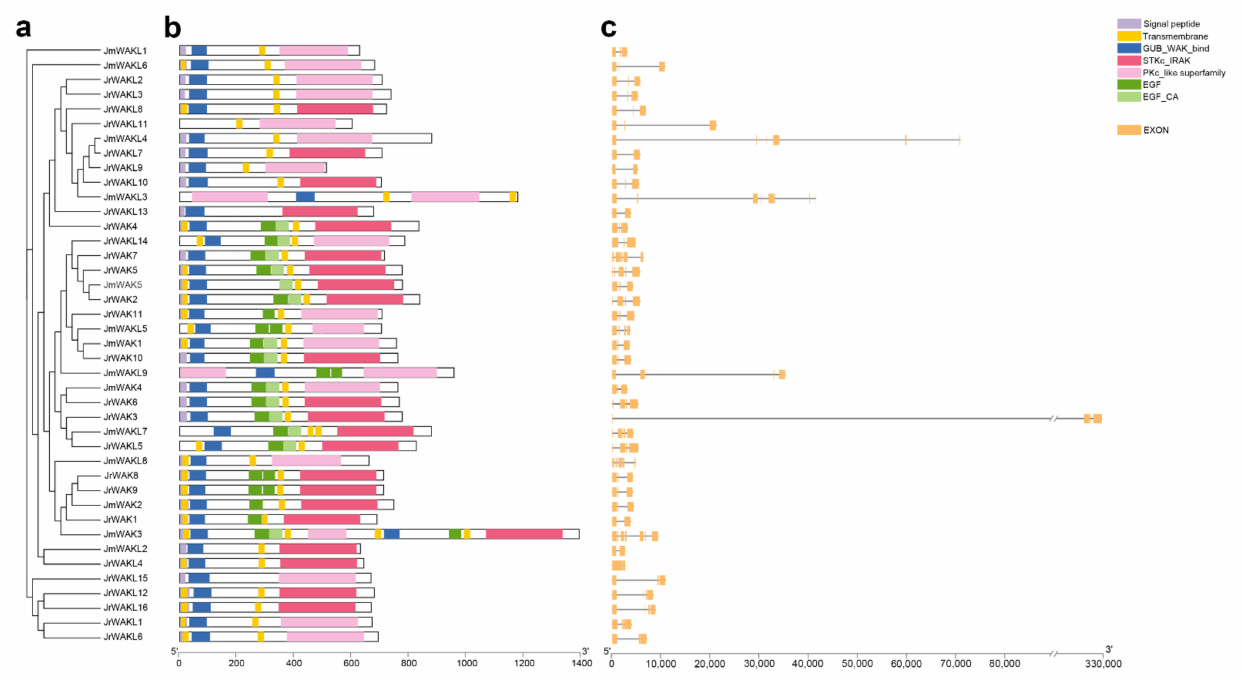
Figure 2. The gene structures and protein domains of WAK/WAKL members. ( a ) Maximum likeli- hood phylogenetic tree of WAK/WAKLs in two Juglans species; ( b ) Protein domains of WAK/WAKLs in two Juglans species. Different domains were represented by different colored boxes; ( c ) Gene structures of WAK/WAKLs in two Juglans species. Yellow boxes indicated exons, and gray lines indicate